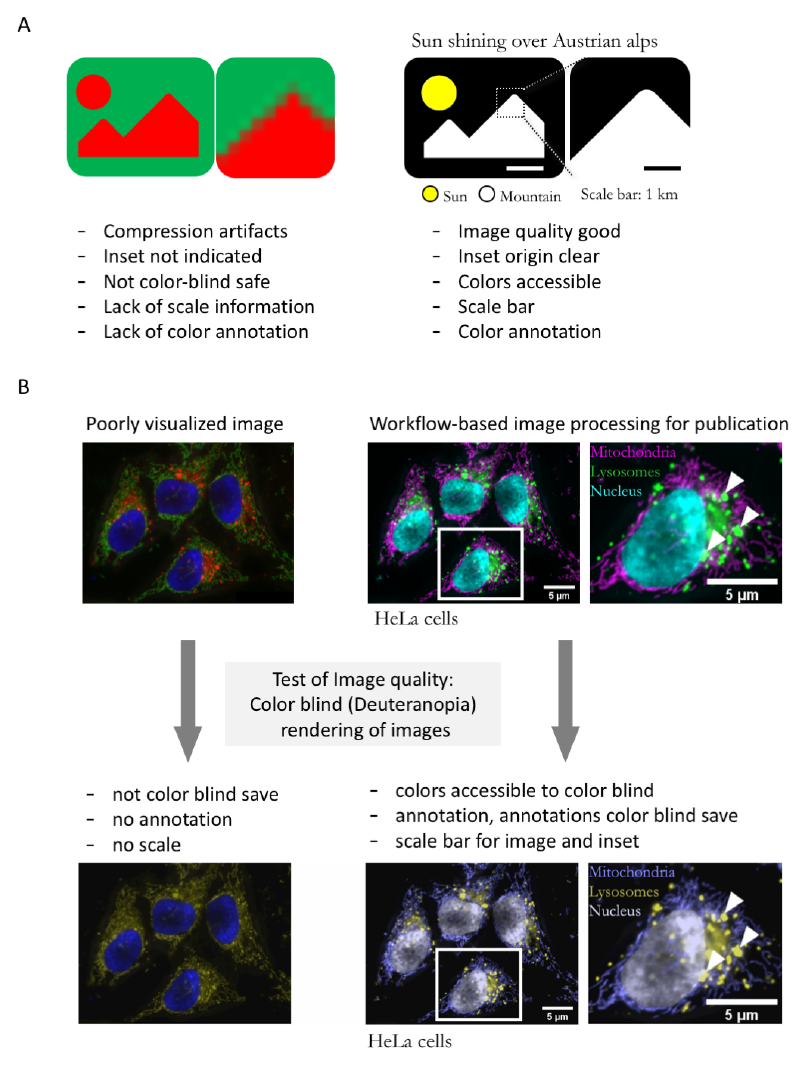
Figure 2. A . Schematic of typical errors in published bioimages and improved version of exemplary image without compression artifacts, and with accessible color-code, annotation, and scale. B . Poorly visualized example image, image after processing with the workflow presented here, and test of image accessibility to color blind